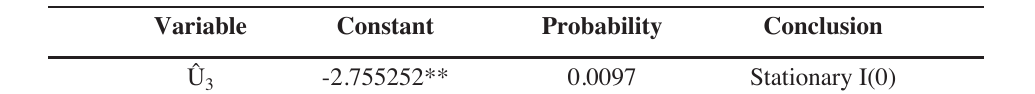
ADF Test for Residuals